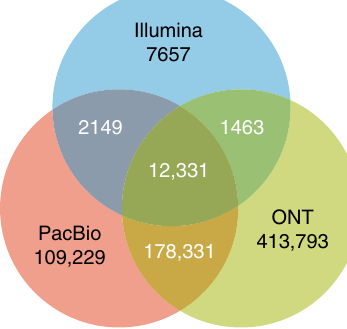
Fig. 2 A Venn diagram that shows the number of undetected known variants by different sequencing technologies or combinations